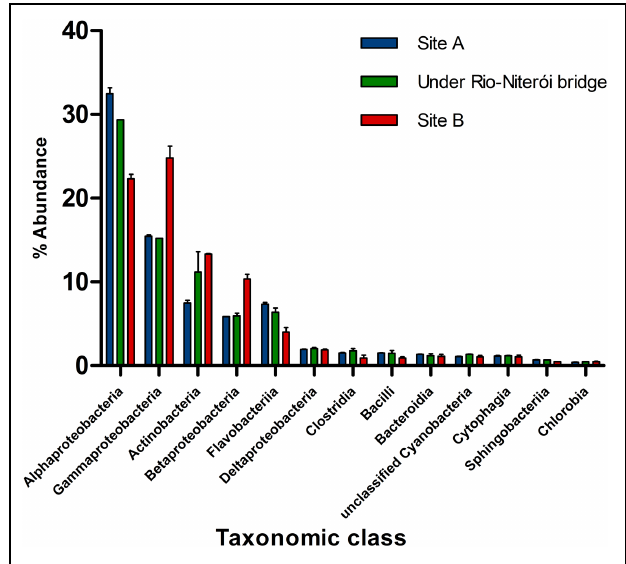
FIGURE 4 | Relative abundance of phylogenetic groups to metagenomes (at class level) in three sites of Guanabara Bay (modified from Gregoracci et al., 2012). Location of sites are shown on Figure 3